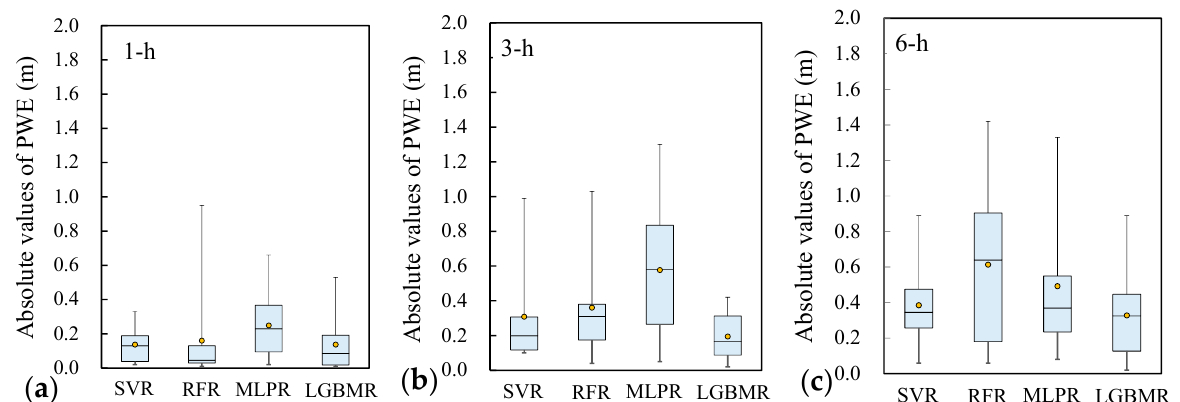
Figure 11. The boxplot in terms of absolute values of peak water-level error (PWE) by four models for ( a ) 1-, ( b ) 3-, and ( c ) 6-h lead times.